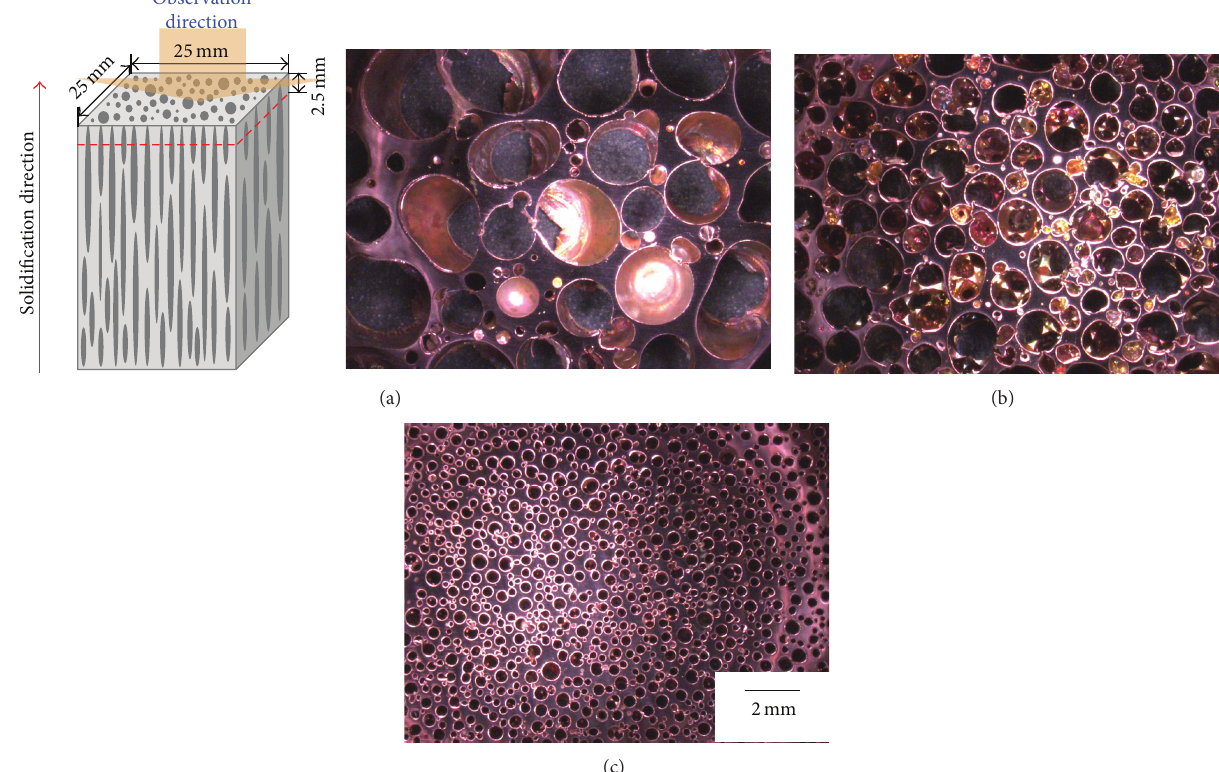
Figure 1: Cross-sectional views perpendicular to the solidification direction of lotus-type porous copper with various specific surface areas: